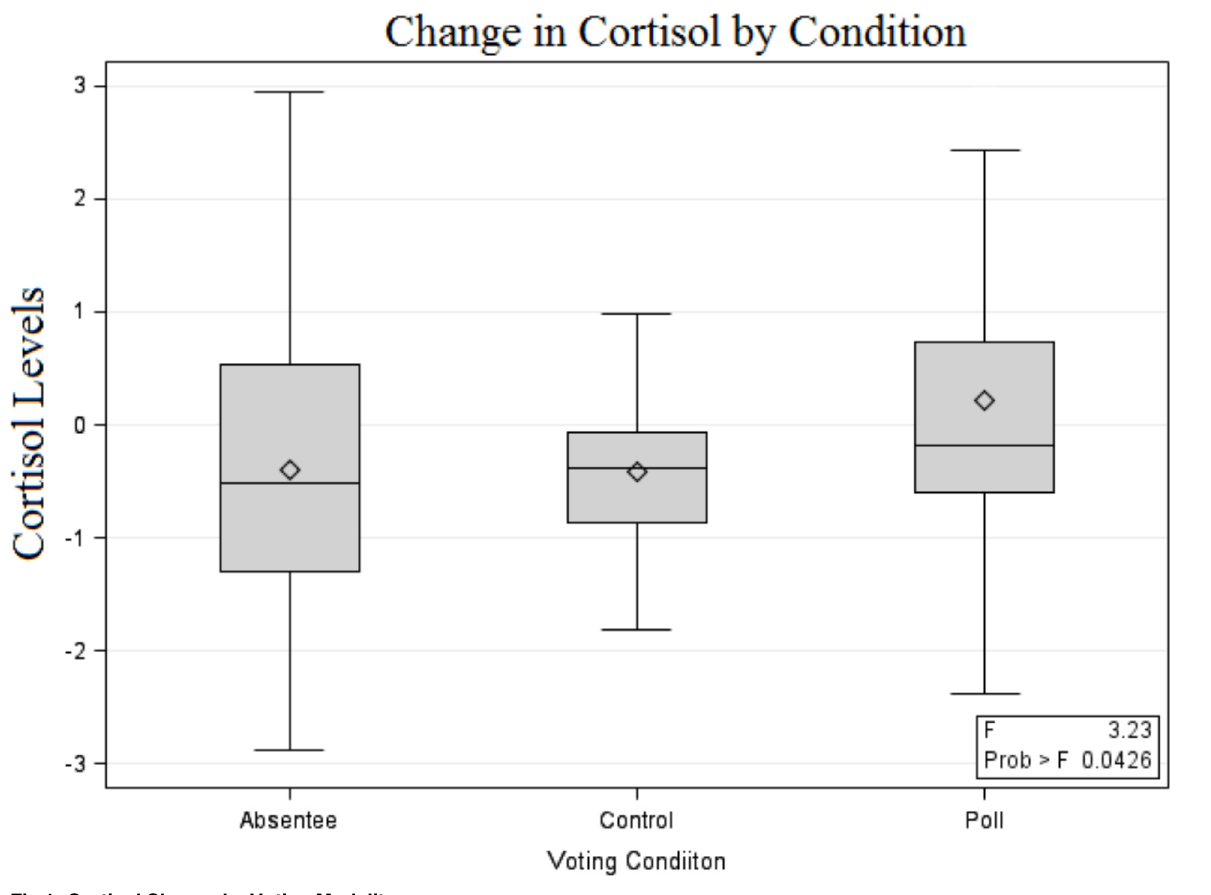
in a regression format. Here the dependent variable is cortisol change and the independent var- iables are dummies for the poll and absentee condition. So in this model, the intercept is the estimate for the control condition as the excluded reference category. The coefficient for the absentee condition is zero and statistically insignificant, indicating cortisol change is this con- dition is indistinguishable from cortisol change in the control condition. The coefficient for the poll condition is. 62 and significant, indicating that mean cortisol change in the poll condition